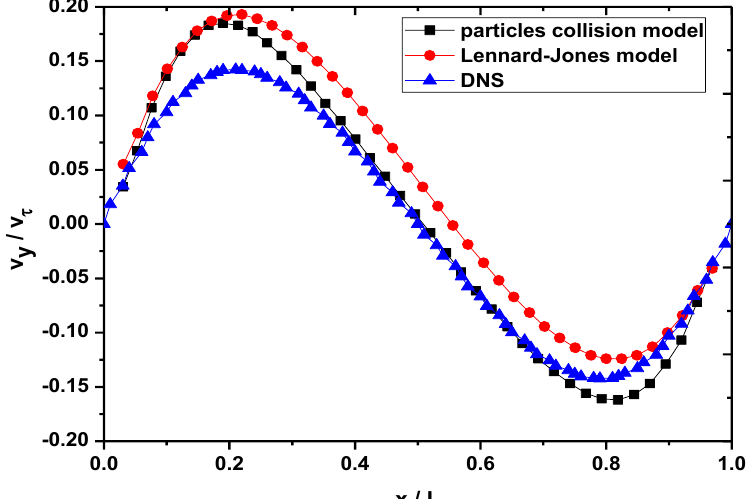
Fig. 6. the velocity vector and streamline of real particles in square cavity.